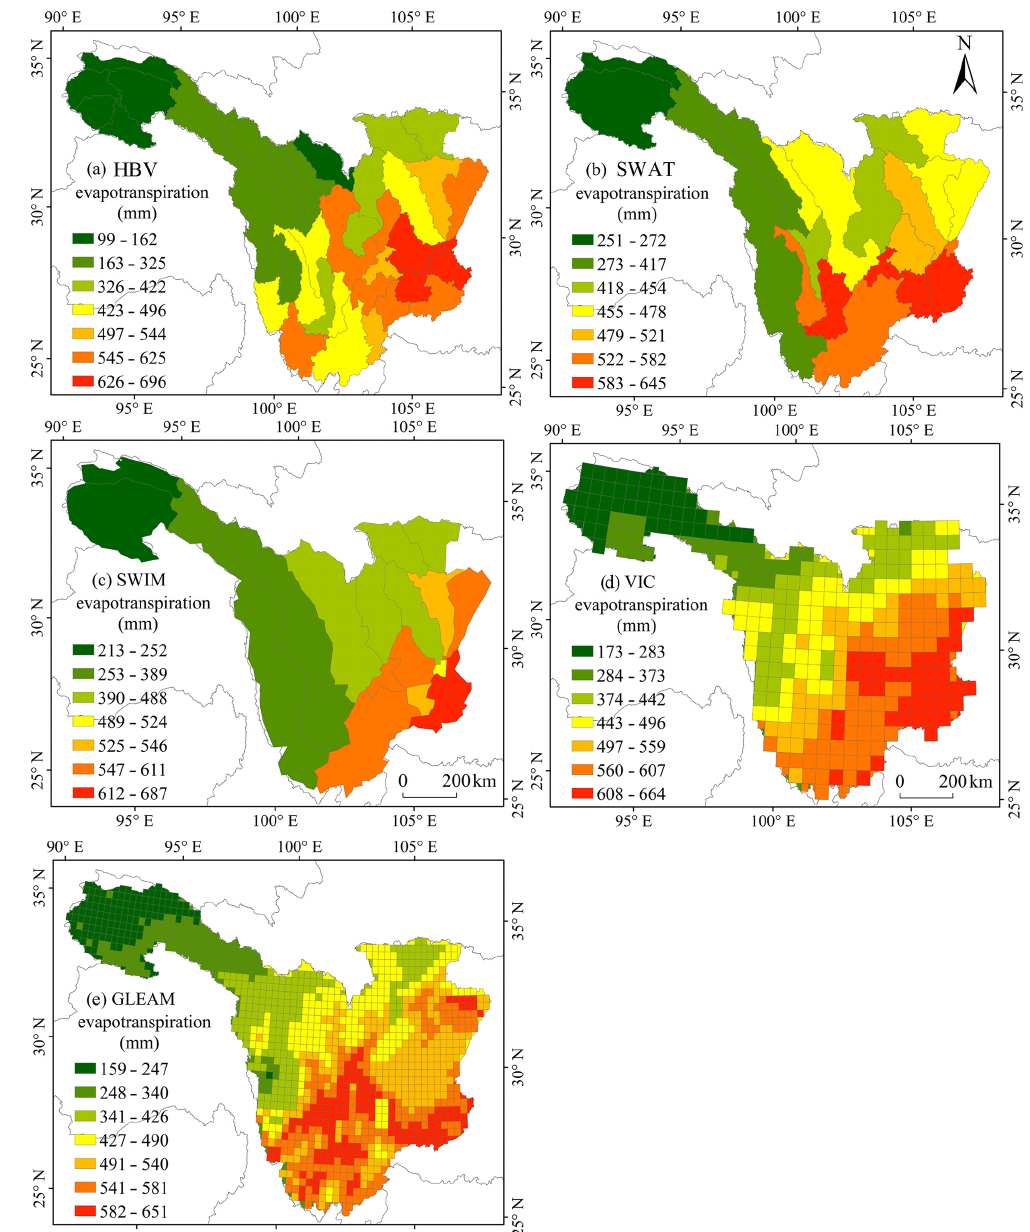
Figure 8. Spatial distribution of multi-year averaged annual evapotranspiration in the upper Yangtze River basin for 1986–2005: HBV output (a) , SWAT output (b) , VIC output (c) , SWIM output (d) and GLEAM data (e)